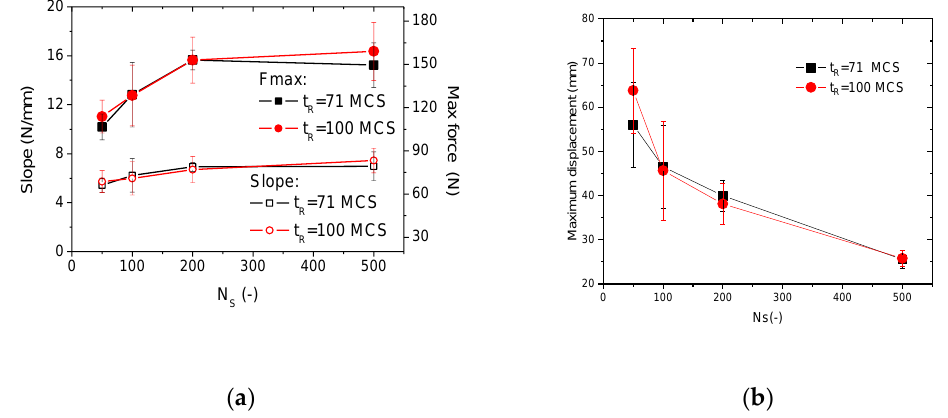
Figure 9. Main extracted mechanical parameters from the bending test: ( a ) slope and maximum force, ( b ) displacement at break as a function of the number of seed points N S and relaxation times t R